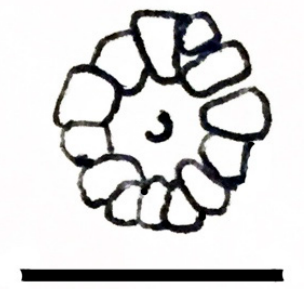
Figure 22. Liangshanella circumbolina . Detail of surface pore consisting of a ring divided into a dozen wedges with a central pit. Scale bar 5 microns. Image Credit: Mark McMenamin. Manawarra Betts et al. 2017 [41]; Range: early Cambrian, Dailyatia odyssei Zone. Manawarra jonesi is an Australian bradoriid.